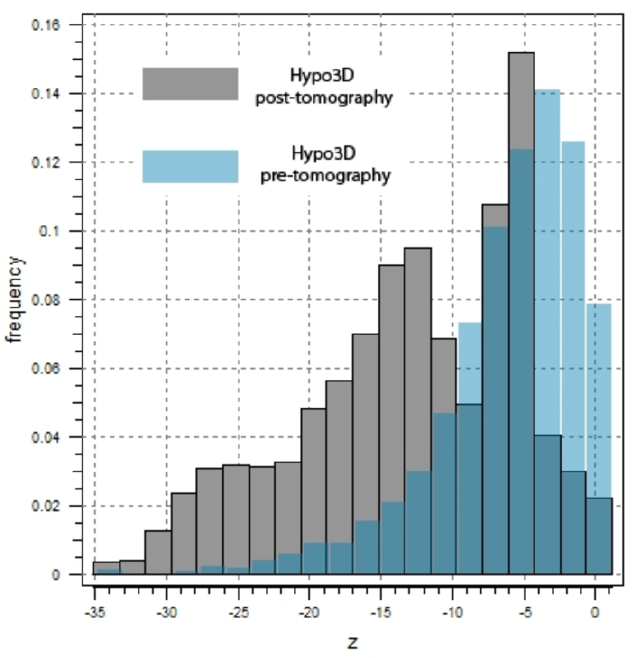
Figure 16. Histograms for the estimated hypocenter depths using the model in Figure 2 (blue) and the model with tomographic velocities